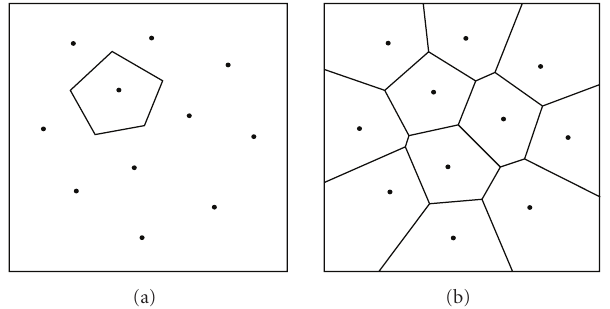
Figure 5: Example of simplicial complex having six vertices, ten edges, and five triangles.